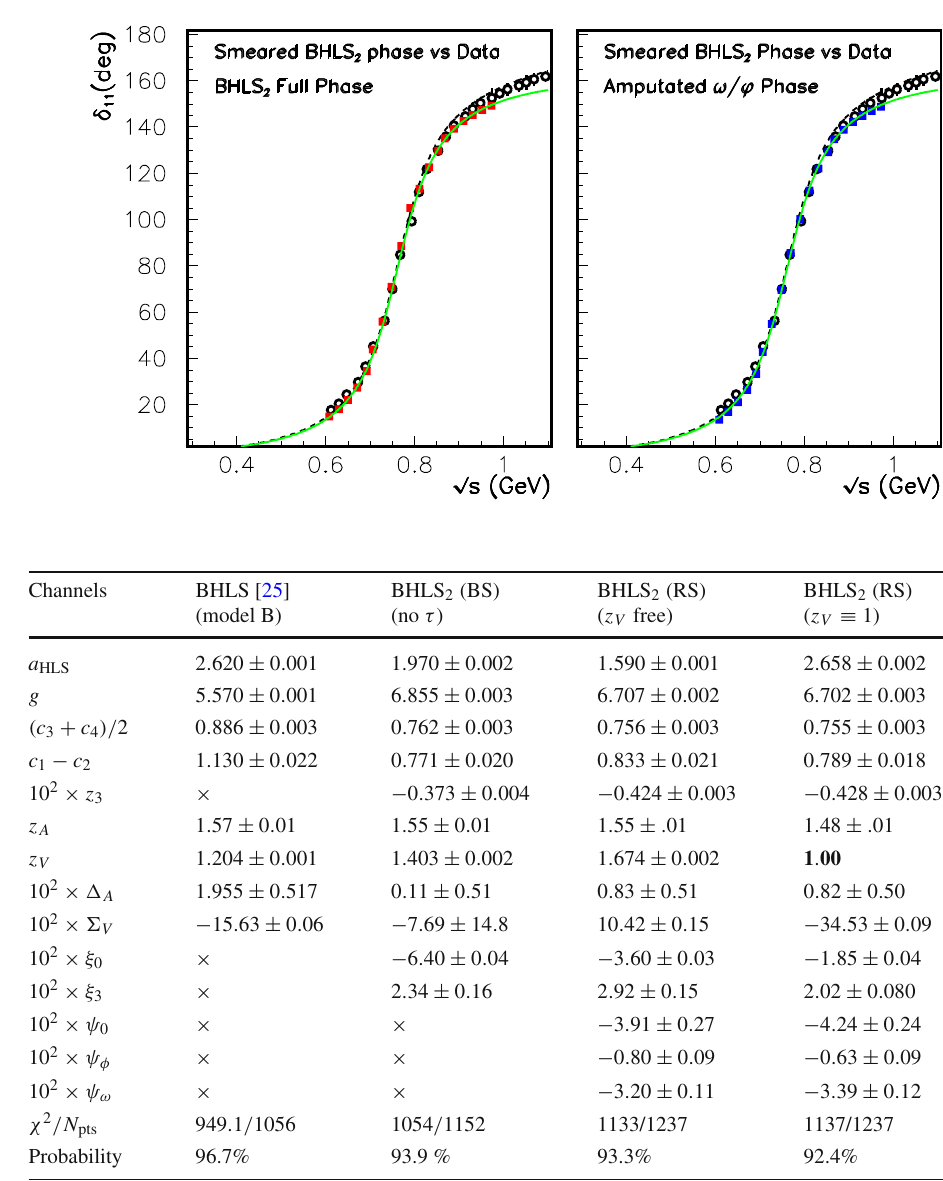
Fig. 11 BHLS 2 δ 11 ππ phase shift versus data [118]: The empty black circles display the experimental data points, the red (left panel) and blue (right panel) square symbols show the smeared BHLS 2 phase as indicated in the respective panels. The green full line represents the JS11 phase shift [43] while the black dashed line is the classical phase shift from [119]